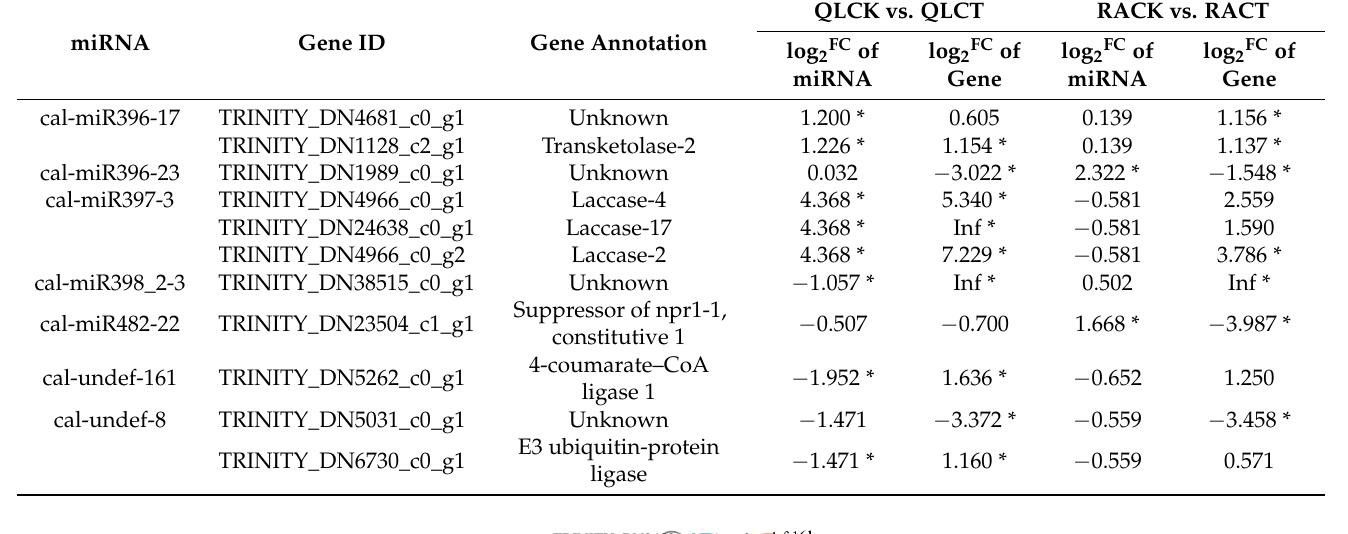
Table 9. Differentially expressed target genes of DEMs after low temperature stress treatments. *—